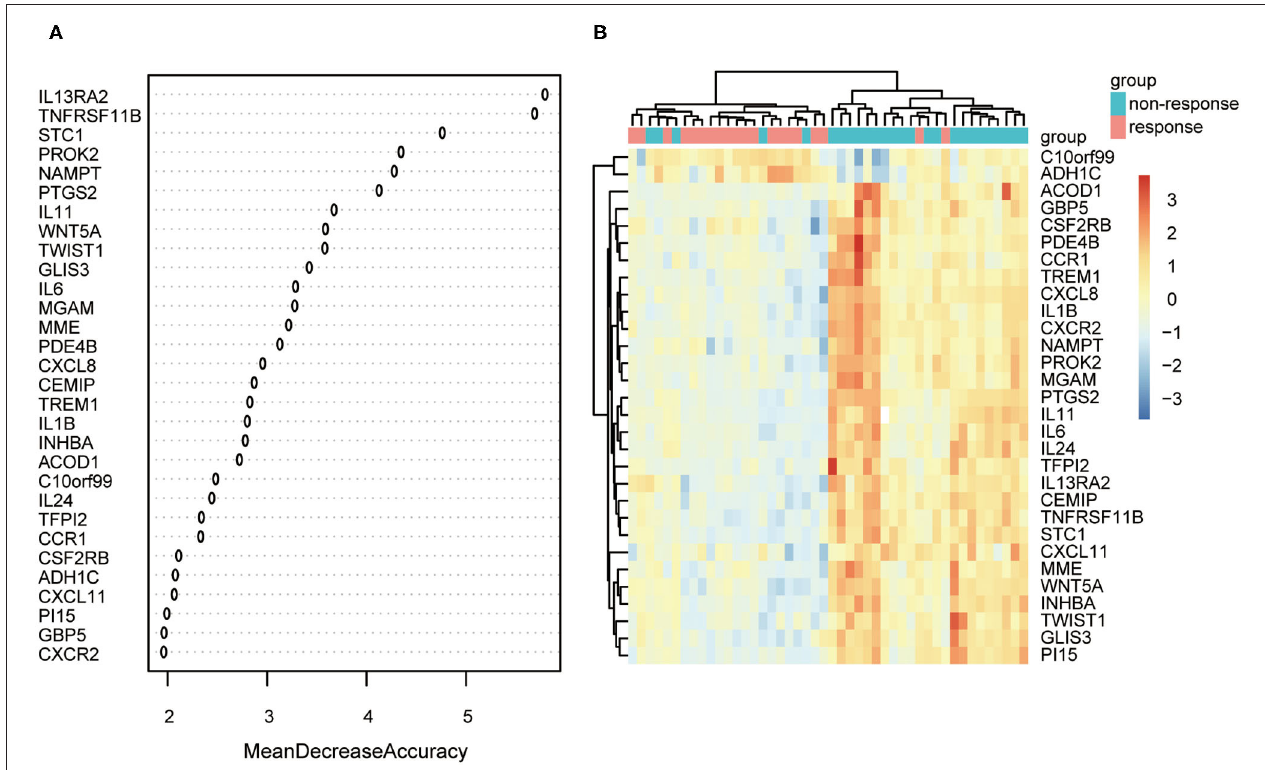
FIGURE 4 | The results of the top 30 genes screened by random forest. (A) The importance of the top 30 genes ranked by mean decrease of accuracy. (B) Heat map of the top 30 genes.